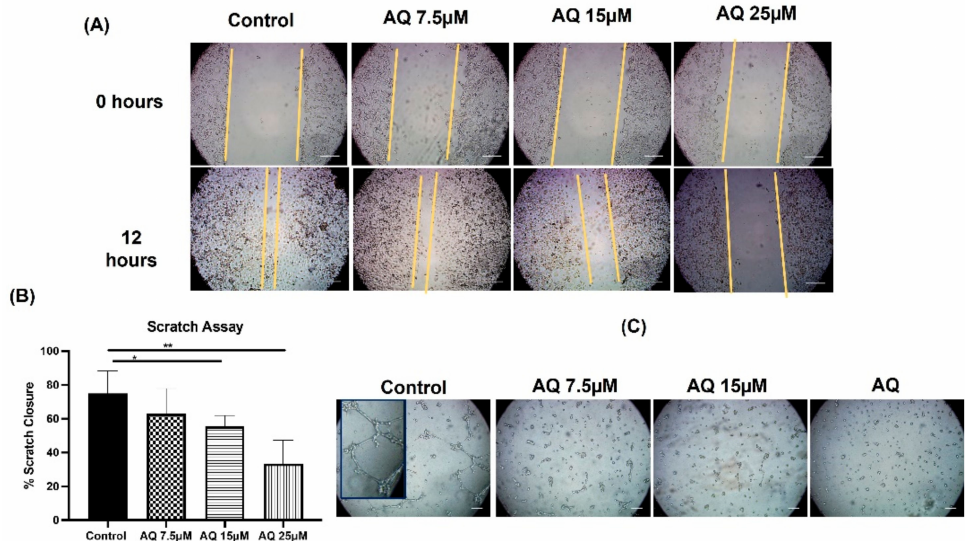
Figure 2. Scratch assay: In vitro scratch wound healing assay with MDAMB-231 cells treated with AQ (7.5, 15 and 25 µ M) with no treatment as a control. ( A ) Shows representative images for indicated treatments ( B ) The graph shows the percent area closure in scratch assay after 12 h. Significance between the groups was analyzed by unpaired student’s t -test. Scale Bar 500 µ m. Data represent mean ± SD ( n = 4). ( C ) Effect of AQ on vasculogenic mimicry.; Inset image in control group represents the closer view of the tubular network.; scale bar represents 500 µ m. * p < 0.05, ** p <